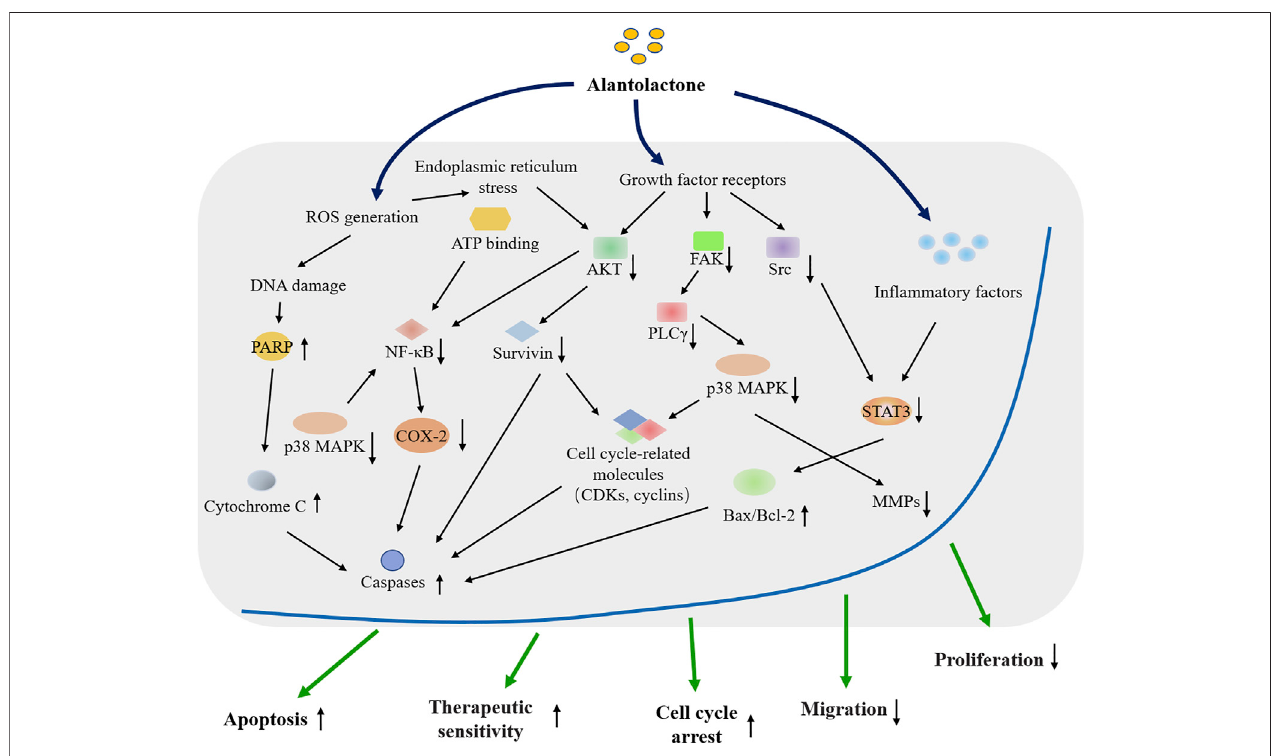
FIGURE 1 | Overview of the cytotoxic effects of the natural compound Alantolactone on cancer research and therapy.